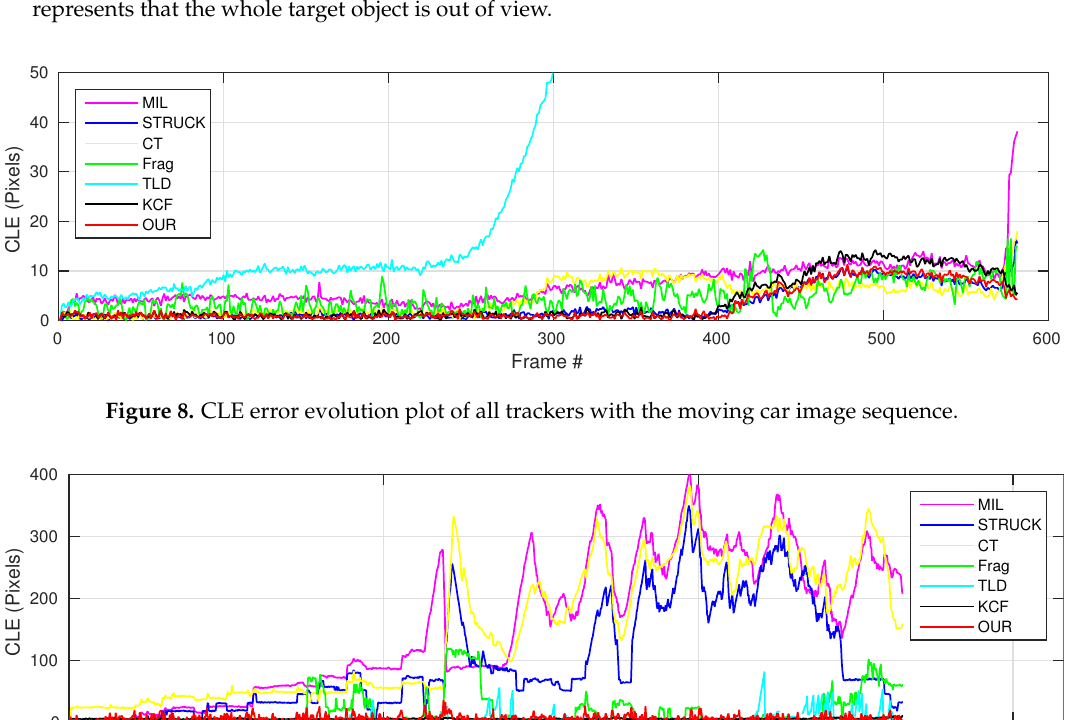
Figure 7. CLE evolution plot of all visual trackers with gas tank image sequence. The grey area represents that the whole target object is out of view.